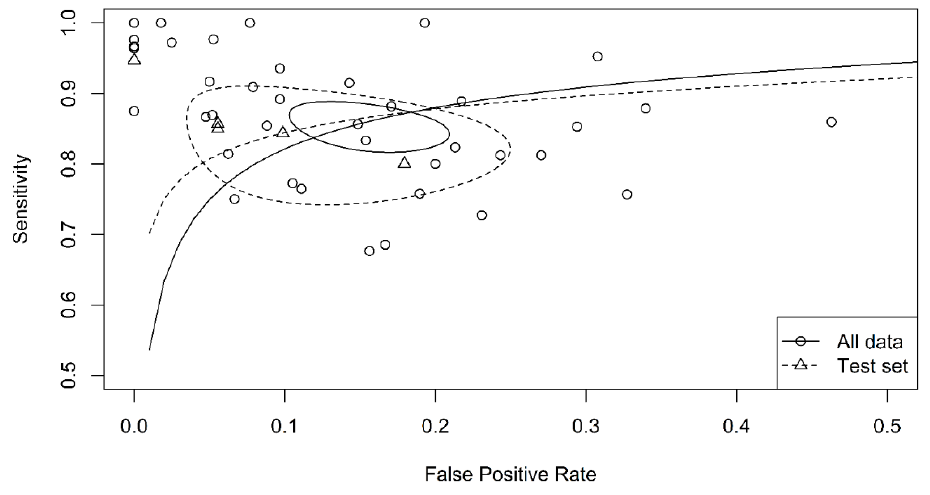
Figure 2. Summary receiver operating characteristic curve graph of the included studies. The accuracy using all data was higher than that of the test set.